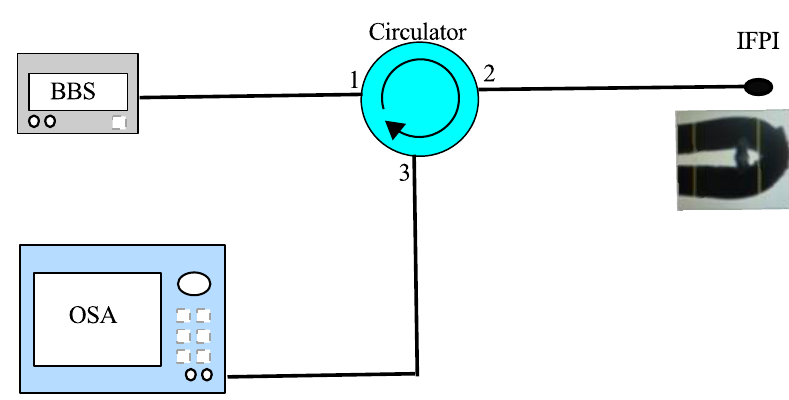
Figure 4. Setup for IFPI